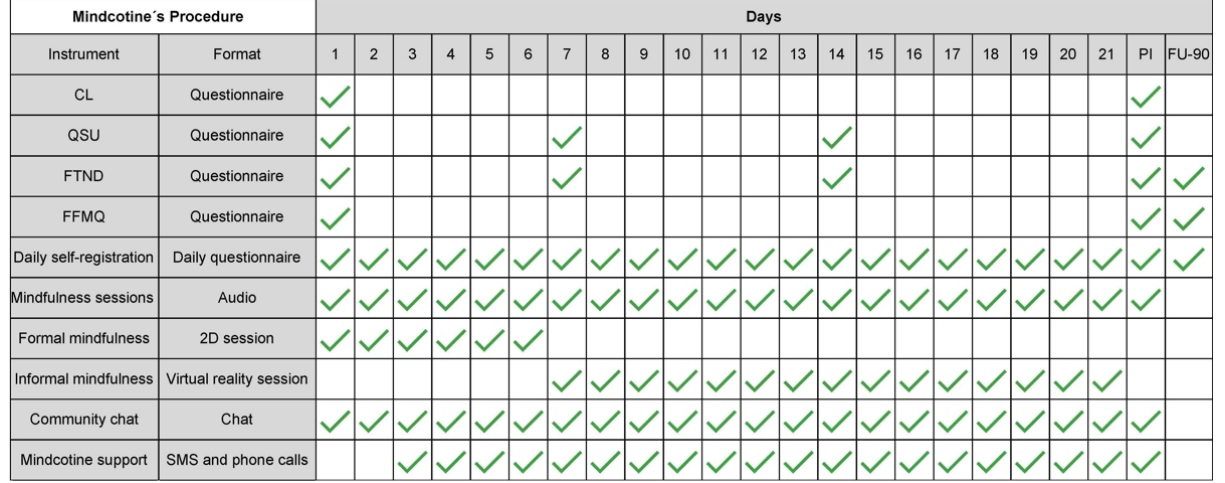
Figure 2. Mindcotine procedure flow diagram. 2D: 2-dimensional; CL: Contemplation Ladder; FFMQ: Five Facet Mindfulness Questionnaire; FTND: Fagerström Test of Nicotine Dependence; FU-90: 90-day follow-up; PI: postintervention; QSU: Questionnaire for Smoking